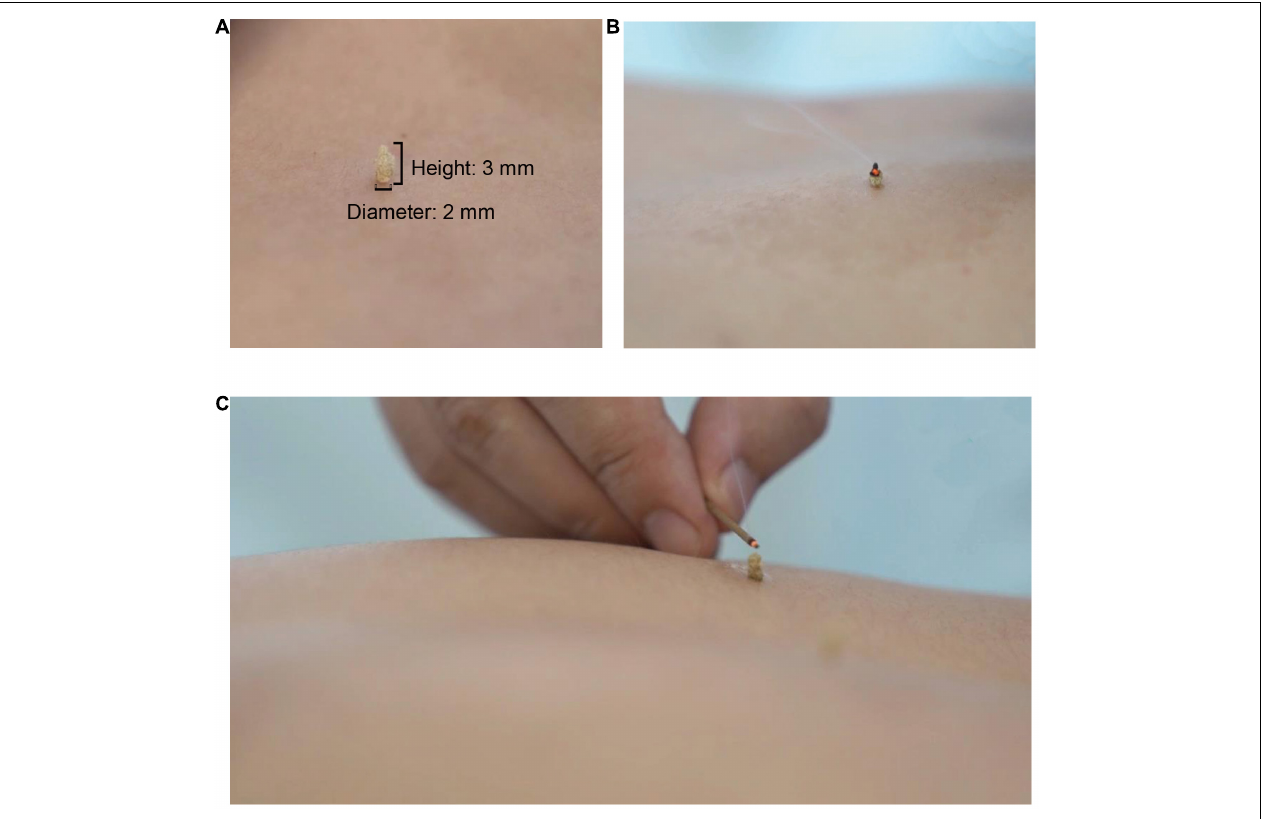
FIGURE 6 | Moxibustion intervention. (A) Presents the size of a moxa cone; (B) and (C) present the demonstration of lighting a moxa